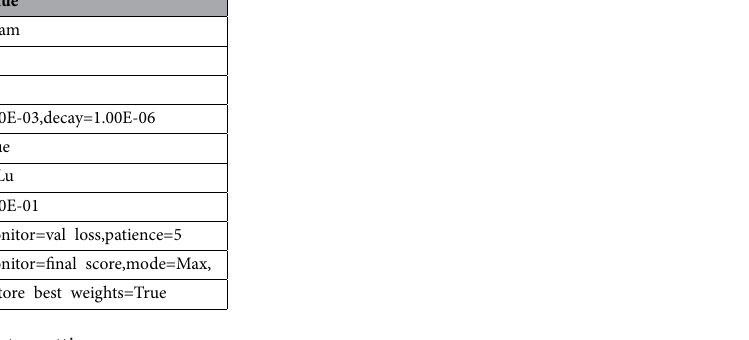
Table 1. Hyperparameter